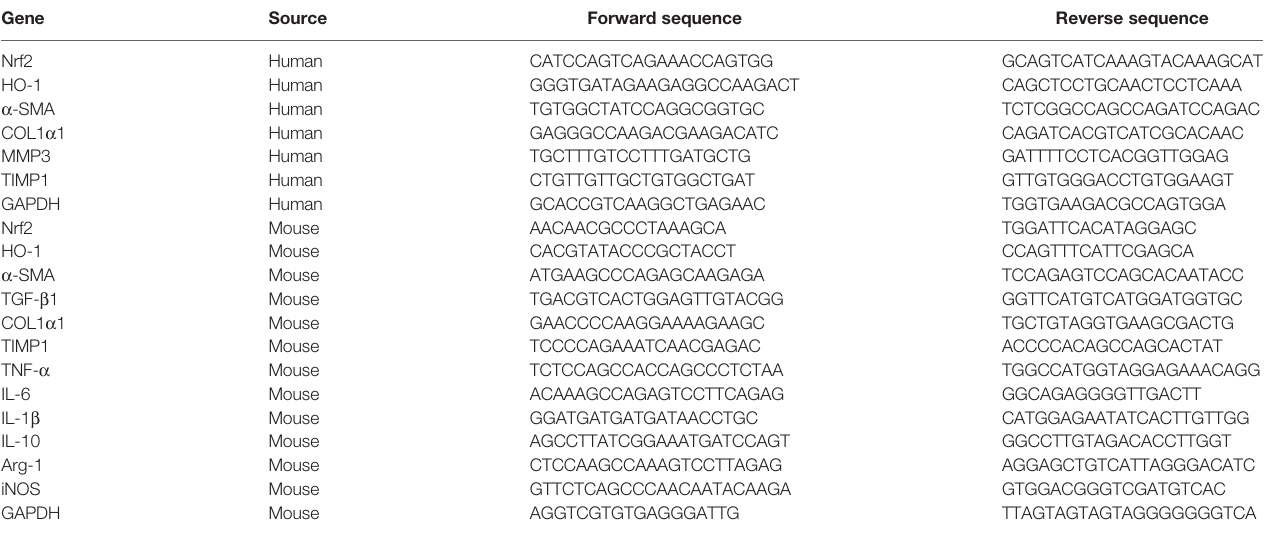
TABLE 1 | Sequences of primers designed for RT-qPCR.